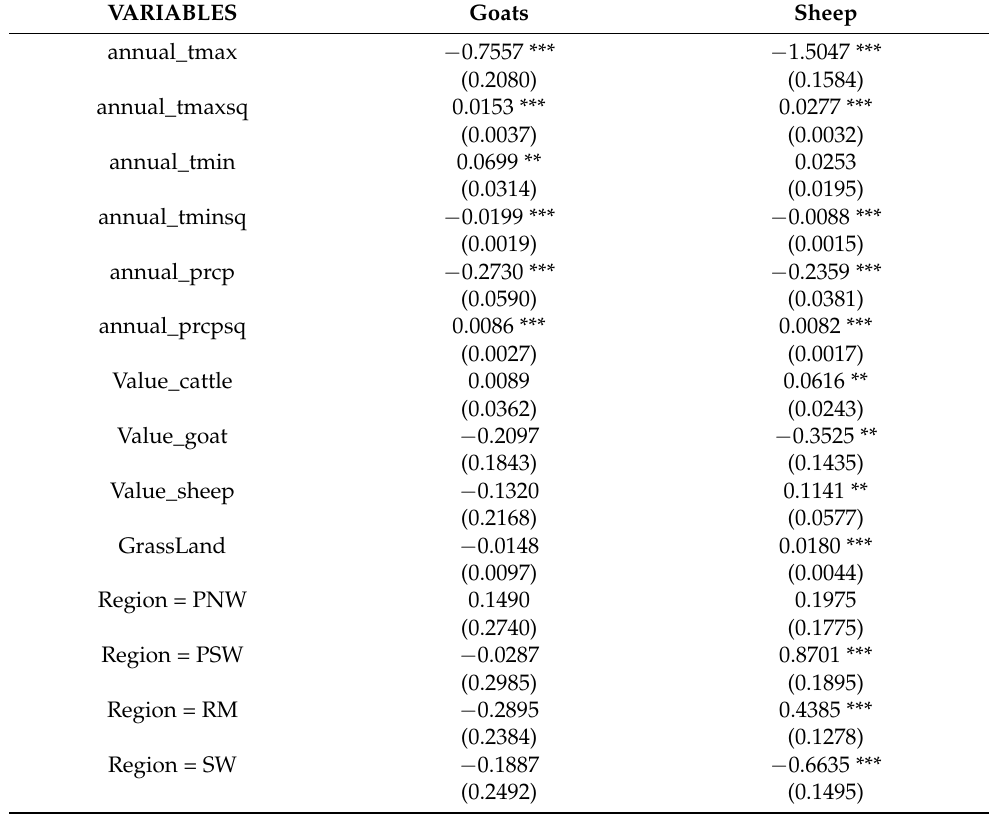
Table A2. Estimation results for on livestock land use share in the west.